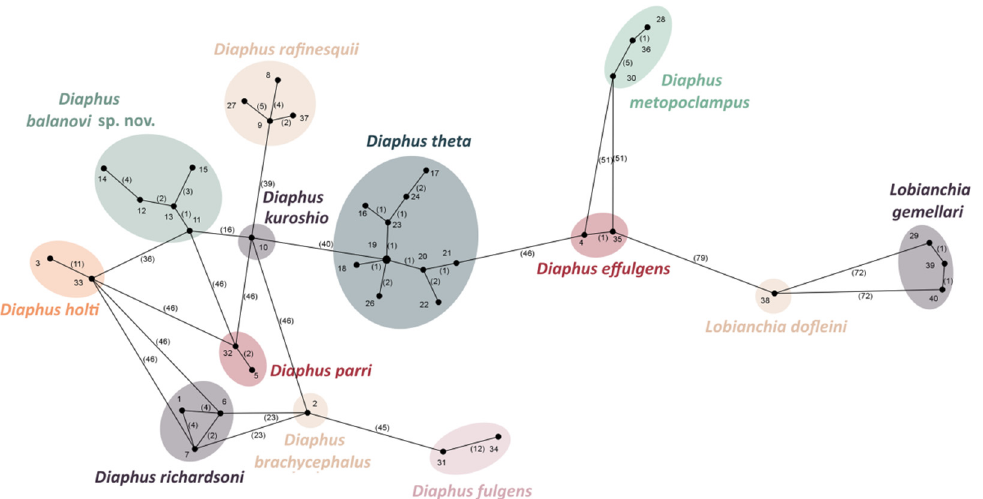
Figure 5. Phylogenetic relationships of Diaphus balanovi sp. nov. and allied species by CO1 mtDNA sequences. Numbers indicate haplotypes (see Table 1 for explanation), numbers of substitutions are given in brackets.